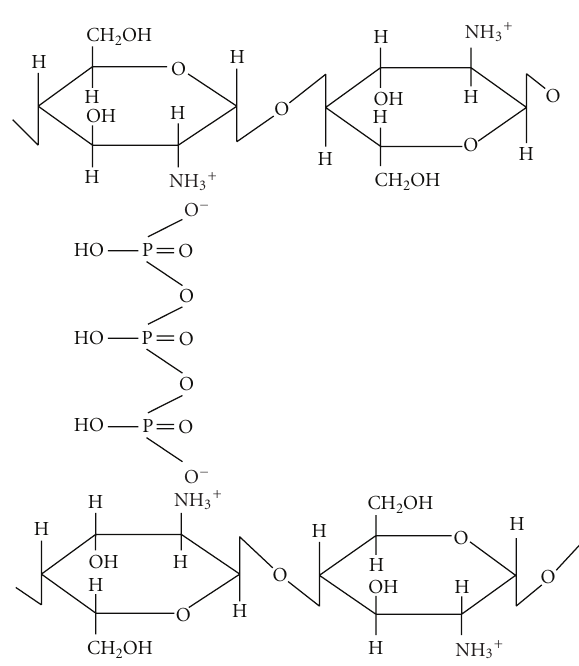
Figure 7: Ionotropic cross-linking of chitosan and